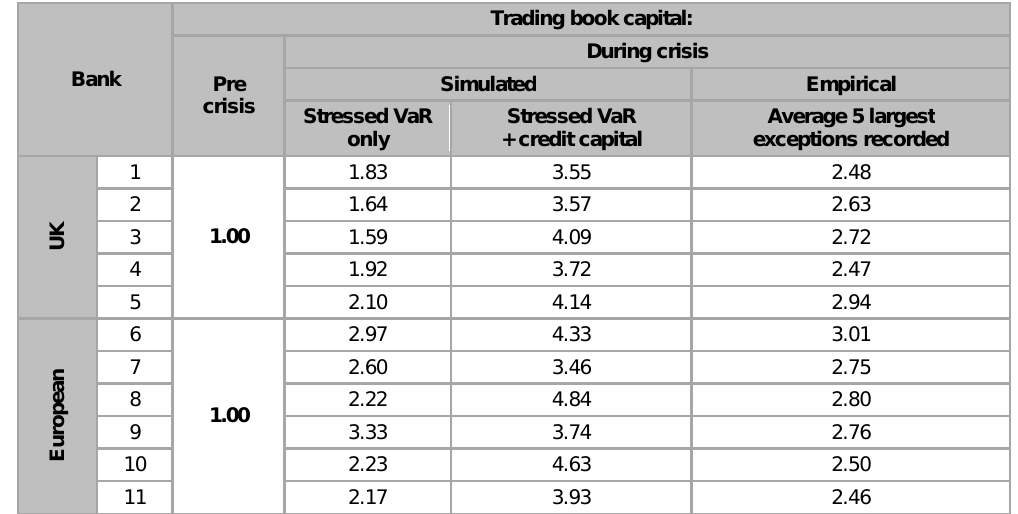
Effect of new Basel II rules governing trading book capital charges.